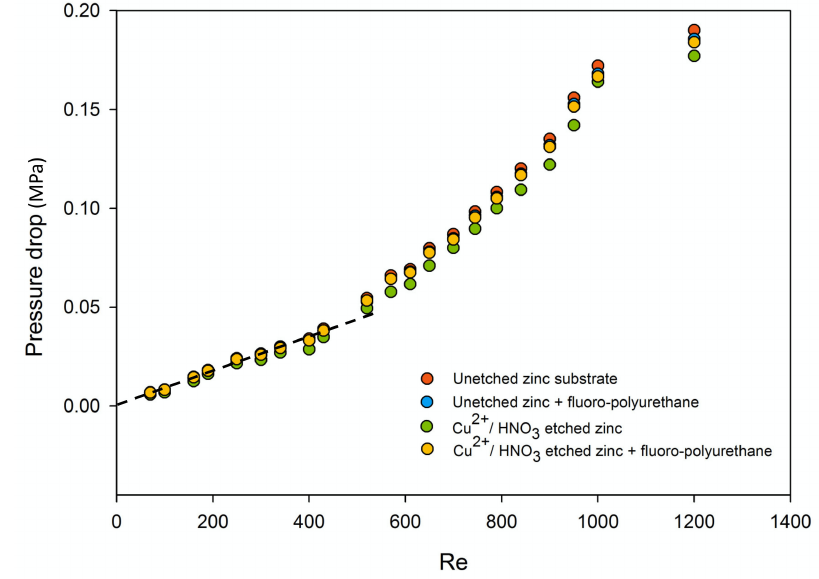
Figure 8. Pressure drop–Reynolds number diagram at h = 192.53 µ m microchannel